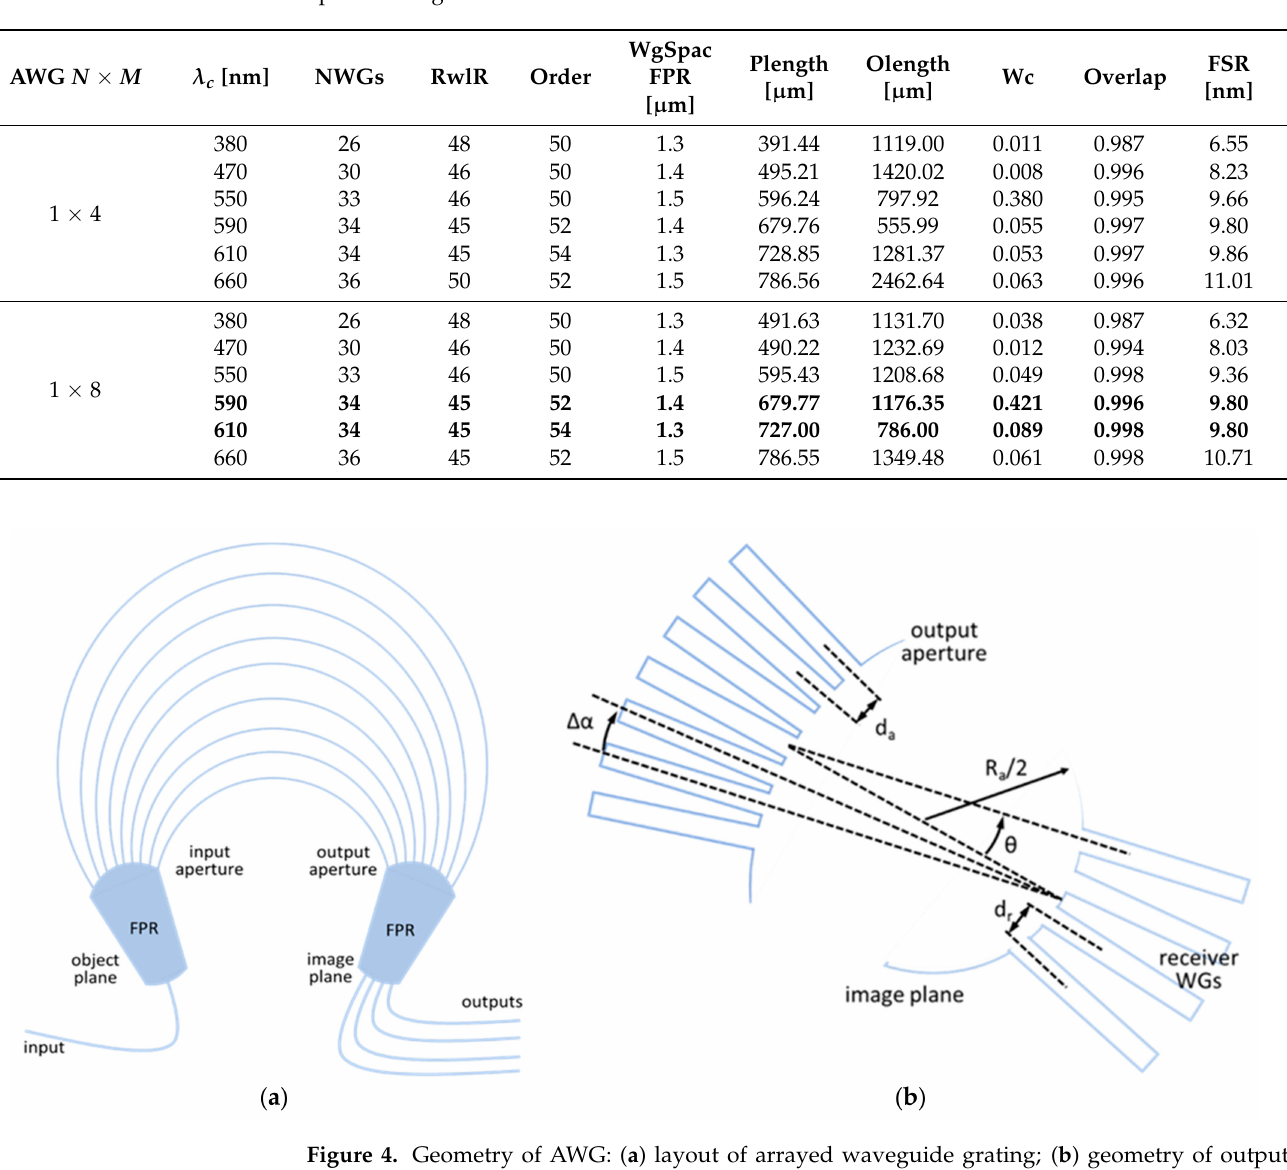
Table 2. AWGs’ geometrical design and simulated performance parameters: AWG N × M —I/O numbers, λ c —central wavelength; NWG—number of WGs in array; RwlR—Rowland radius; order